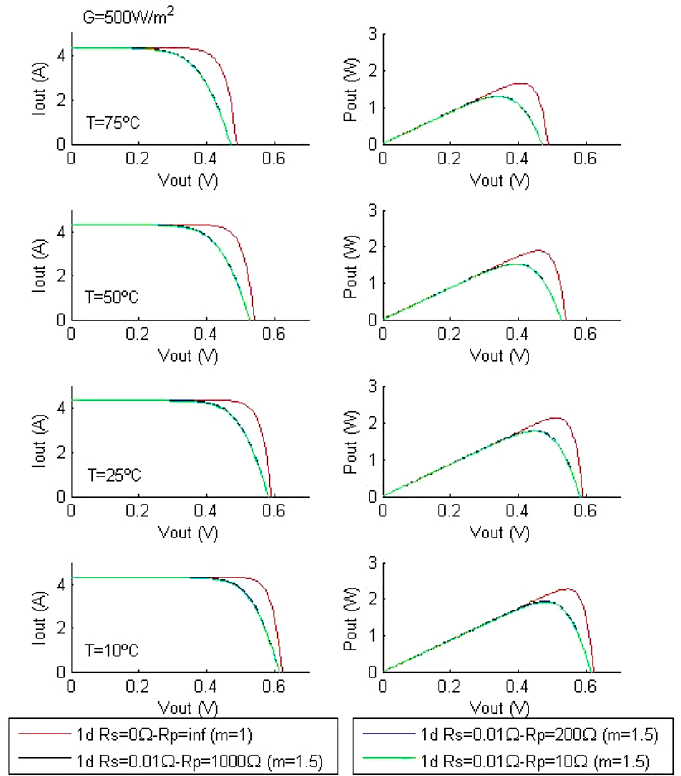
Figure 6. Characteristic curves in function of temperature and parallel resistance R p , with a constant resistance R s (G = 500 W/m 2 ).